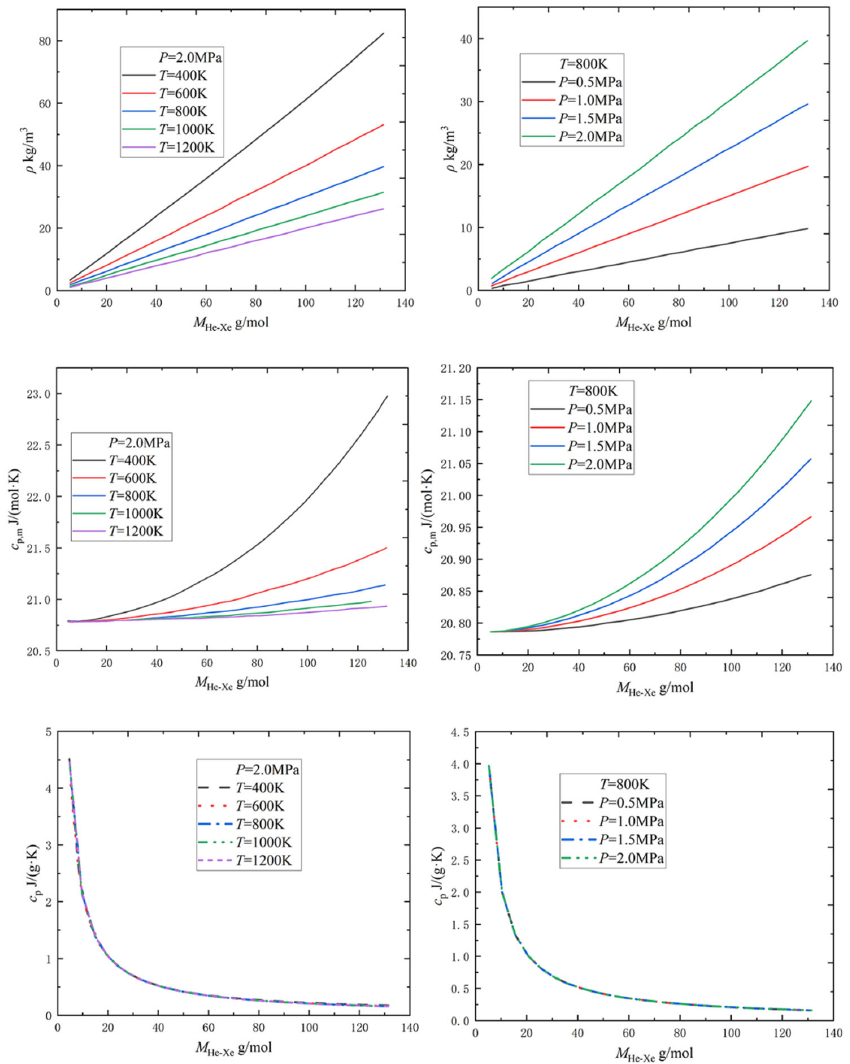
Figure 2. Variation of thermodynamic properties of helium–xenon gas mixture with molar mass of helium–xenon gas mixture [1,8].